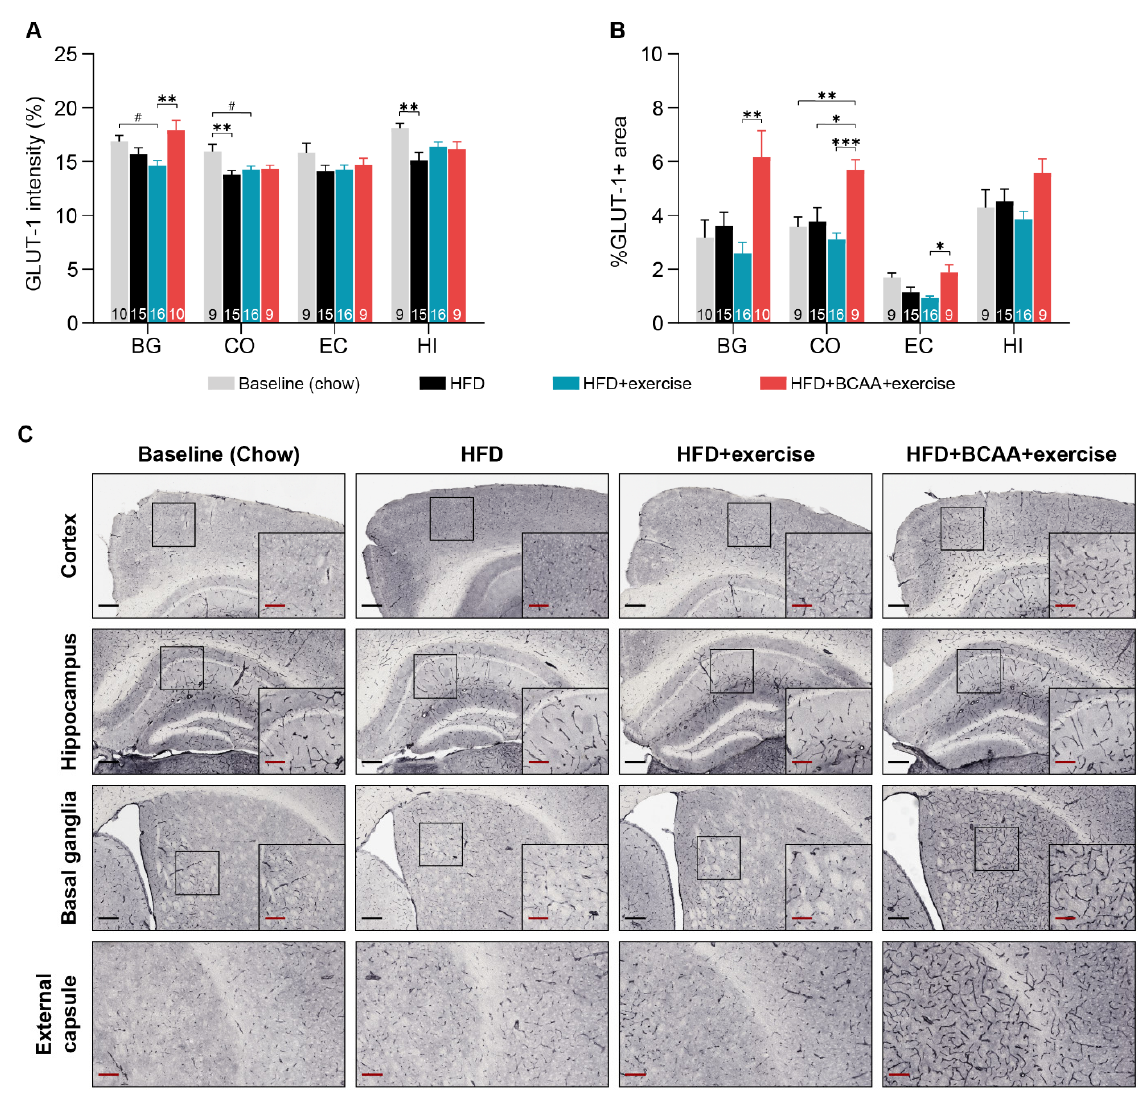
Figure 9. Cerebrovascular integrity. Immunohistochemical analysis of glucose transporter 1 (GLUT-1) as a measure of cerebrovascular integrity in different brain regions of interest (basal ganglia (BG), cortex (C), external capsule (EC), and hippocampus (HI)). ( A ) GLUT-1 staining intensity is a meas- ure of the amount of GLUT-1 in the capillaries. ( B ) The percentage of GLUT-1 positive staining per area is representative of vascular density. ( C ) Representative images of the GLUT-1 staining (black scale bar = 200 μ m; red scale bar = 100 μ m). Group differences between young chow-fed animals (baseline), HFD, HFD + exercise, and HFD + BCAA + exercise groups were analyzed. High-fat diet (HFD), branched-chain amino acids (BCAA). Data are presented as mean ± SEM. * p < 0.05, ** p < 0.01, *** p < 0.001, # 0.05 < p < 0.08 (trend).